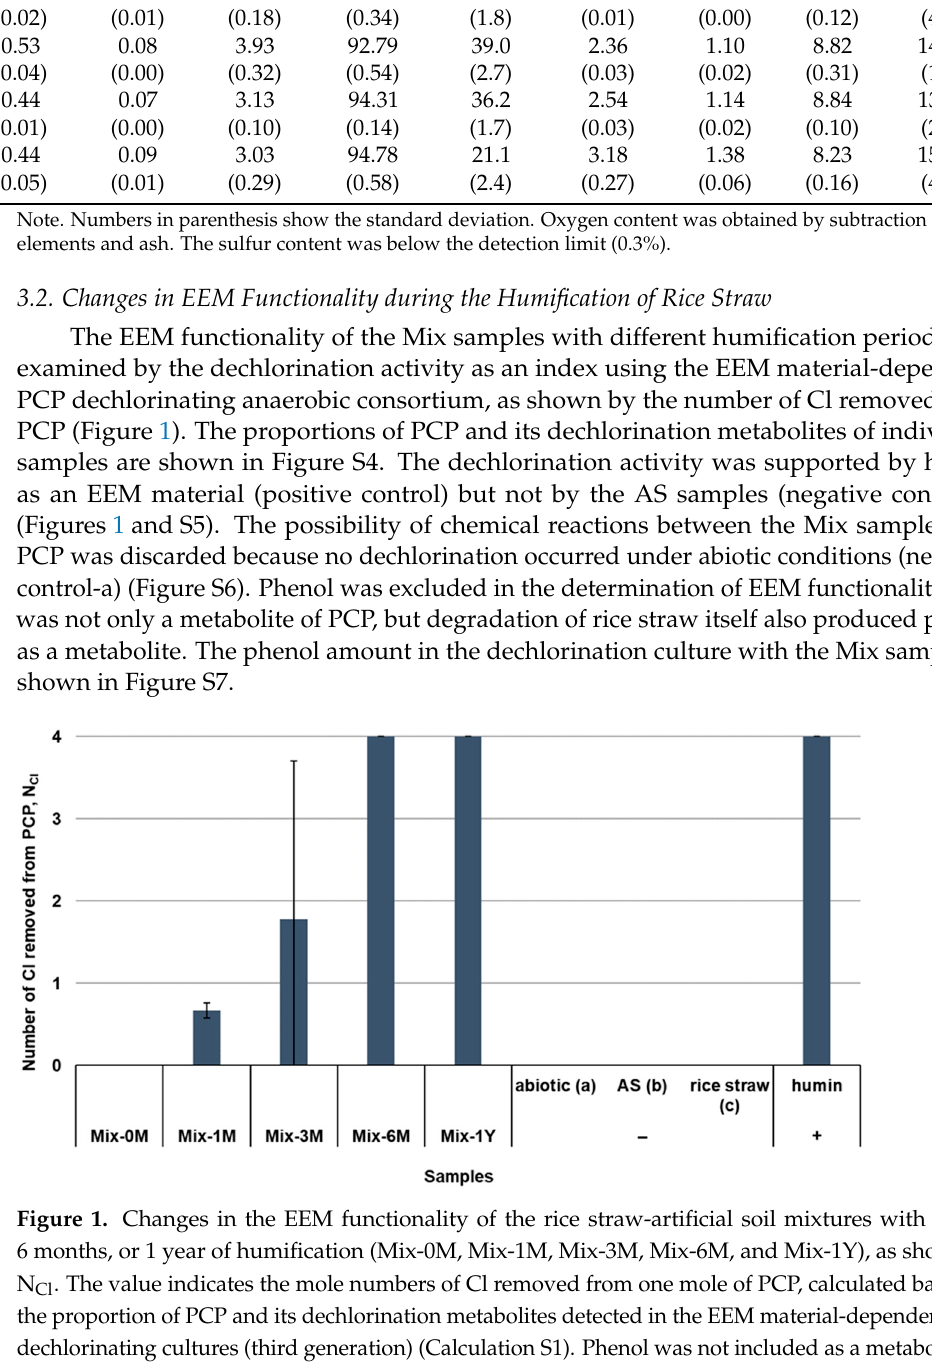
Table 1. Elemental composition, pH, and EC of rice straw ‐ artificial soil mixtures.